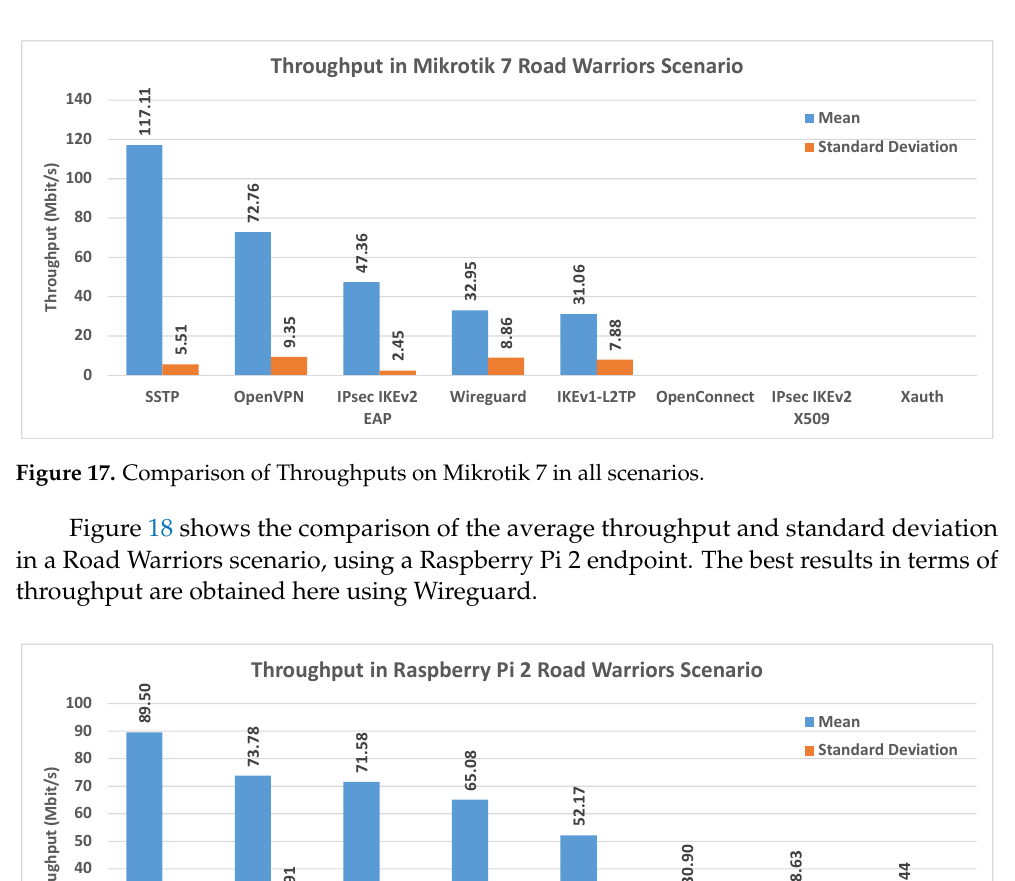
Figure 16. Comparison of Throughputs on Android 11 in all scenarios.